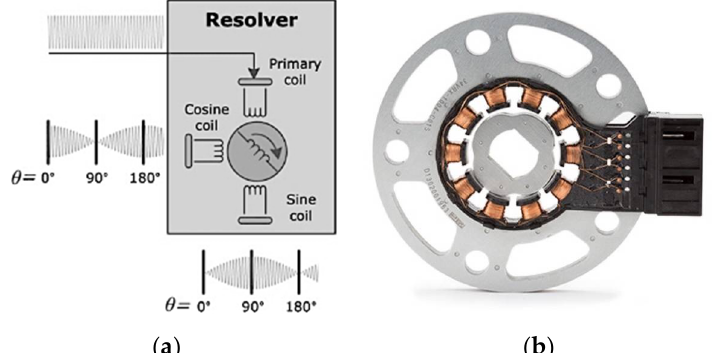
Figure 2. Variable Reluctance (VR) resolver position sensor. ( a ) Operating principle [13]; ( b ) Exemplary sensor for Battery Electric Vehicles (BEVs), reproduced from [15]. Copyright 2000–2020 MinebeaMitsumi Inc.